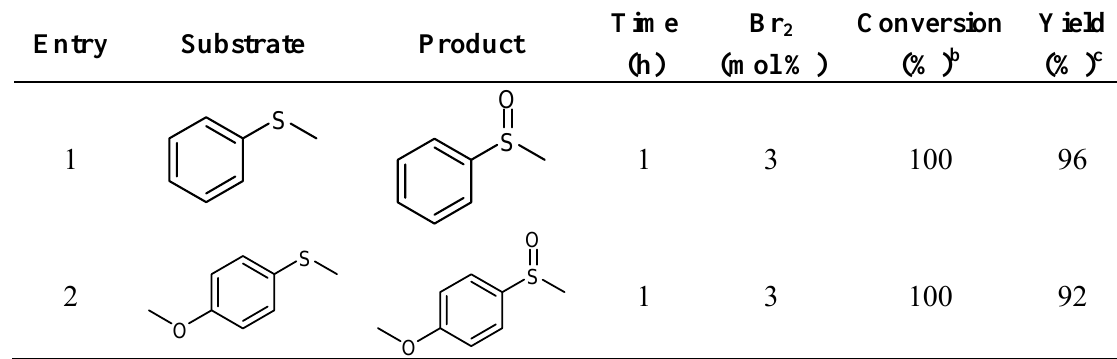
Table 2. Catalytic aerobic oxidation of sulfide in a small amount of water.